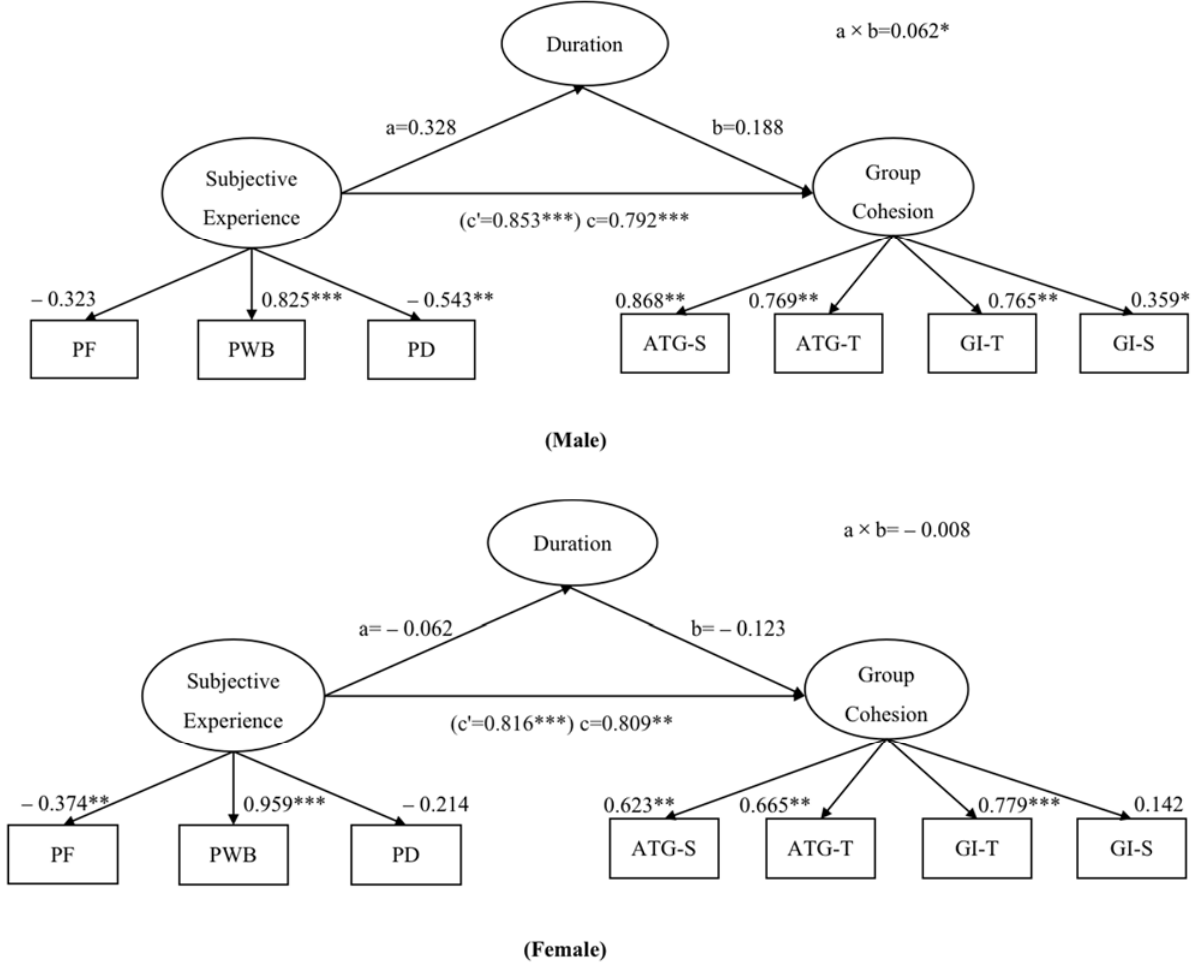
Figure 1. Mediation model for male group (N = 63) and female group (N = 67). Note: PF = Psychological Fatigue, PWB = Positive Well-Being, PD = Psychological Distress, GI-T = Group Integration—Task, GI-S = Group Integration—Social, ATG-T = Individual Attractions to Group—Task, ATG-S = Individual Attractions to Group—Social. Summary standardized path coefficients representing the effects of Subjective Exercise Experience and income rating on Group Cohesion. All values represent standardized estimates/coefficients. *** p < 0.001, ** p < 0.01, * p < 0.05.